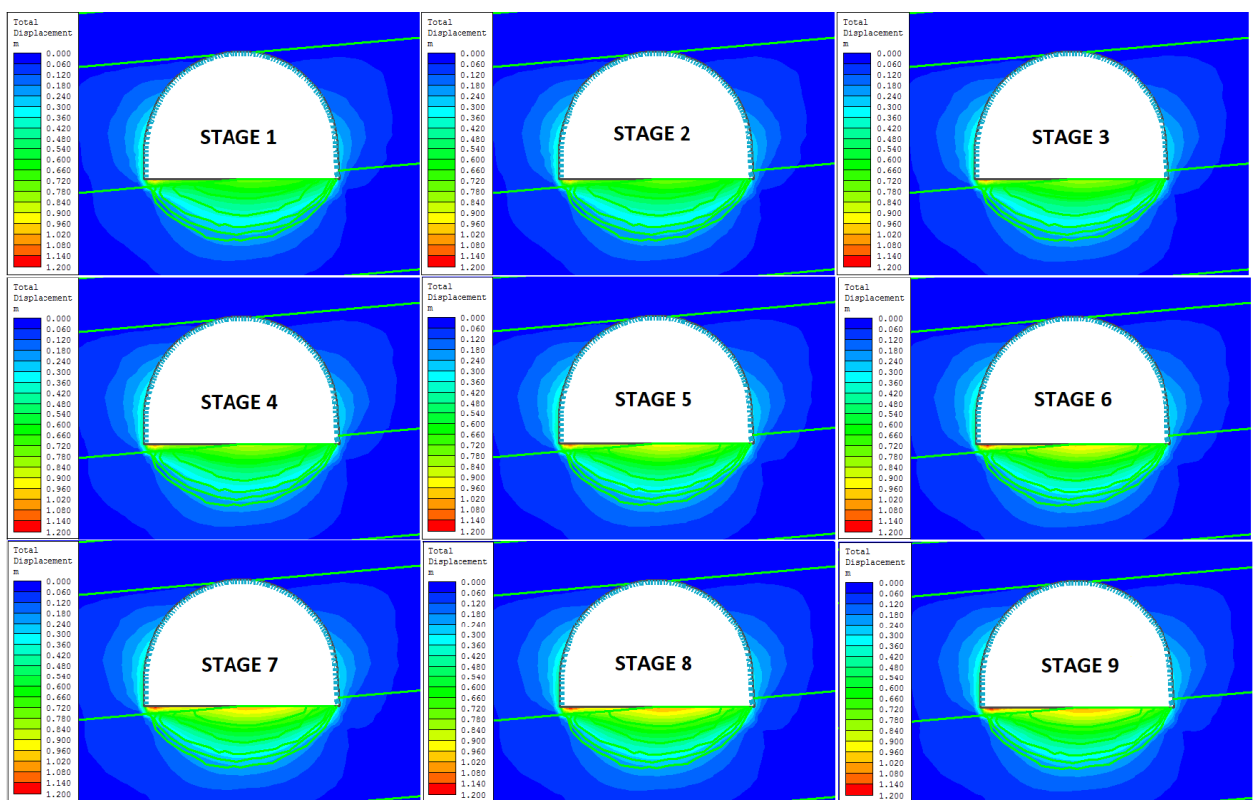
Figure 26. Stages of the numerical simulation of the impact of water saturation of the rocks beneath the floor of roadway D-2 on the magnitude of the floor heave, and with various geomechanical properties: gray color—dry rocks, green—rocks after 3 h of soaking with water, yellow—rocks after 6 h of soaking, purple—rocks after 12 h of soaking, dark blue—rocks after 24 h of soaking. Figure 27. Convergence of the D-2 roadway versus the extent of the saturation zone in the floor rocks. Table 6. Comparison of the convergence results from numerical model of roadway D-2 with the in situ measurements of the 614th meter of the roadway.